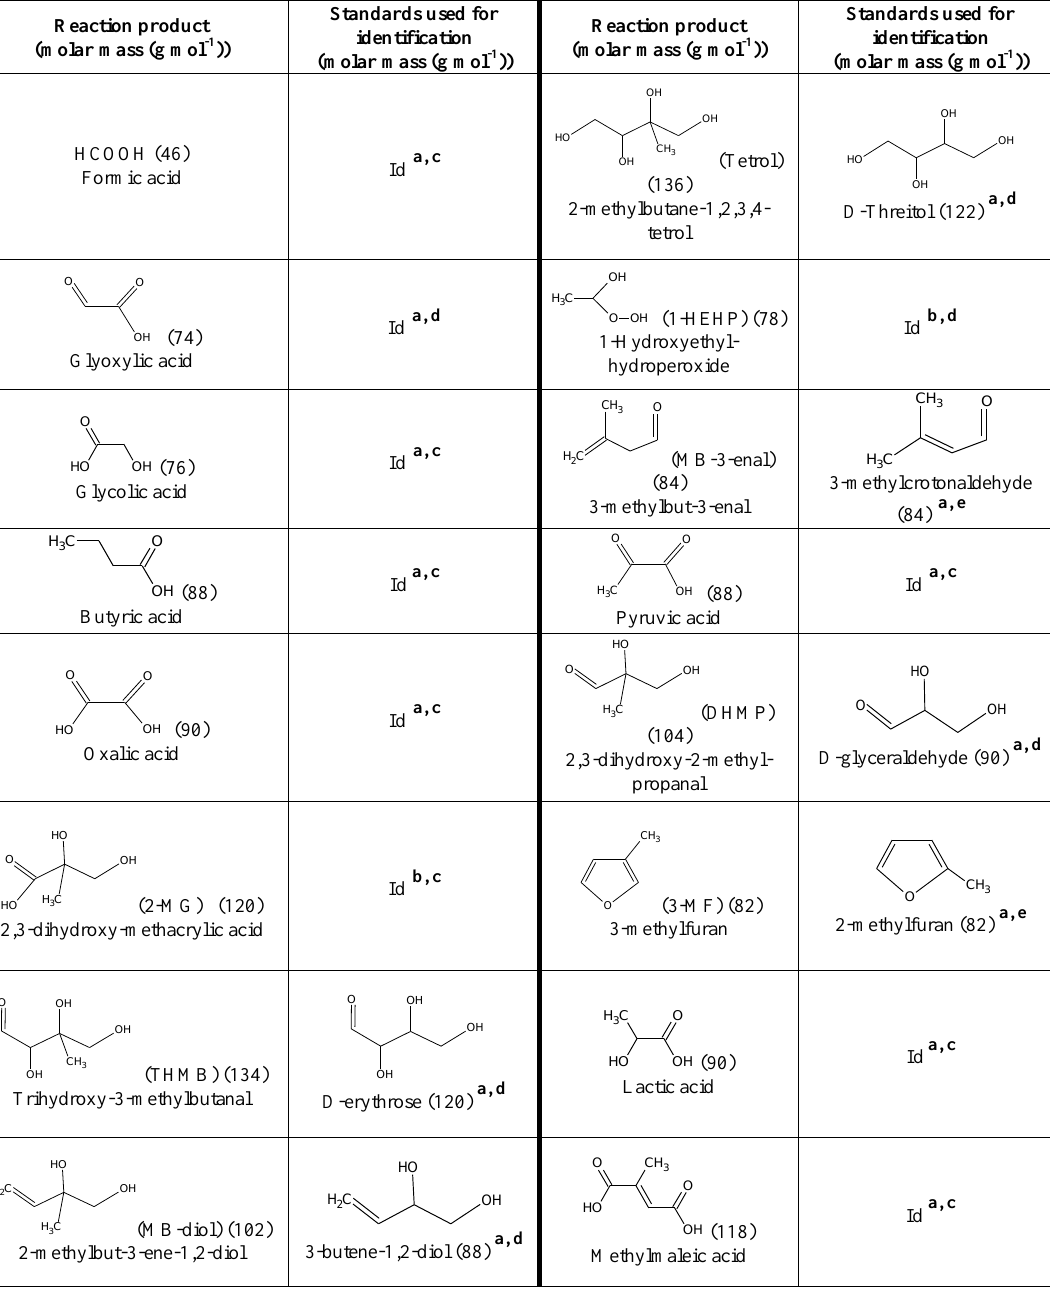
Table 1. Identification and quantification of reaction products (experiments 1 and 2), in the mass range 60–150Da.